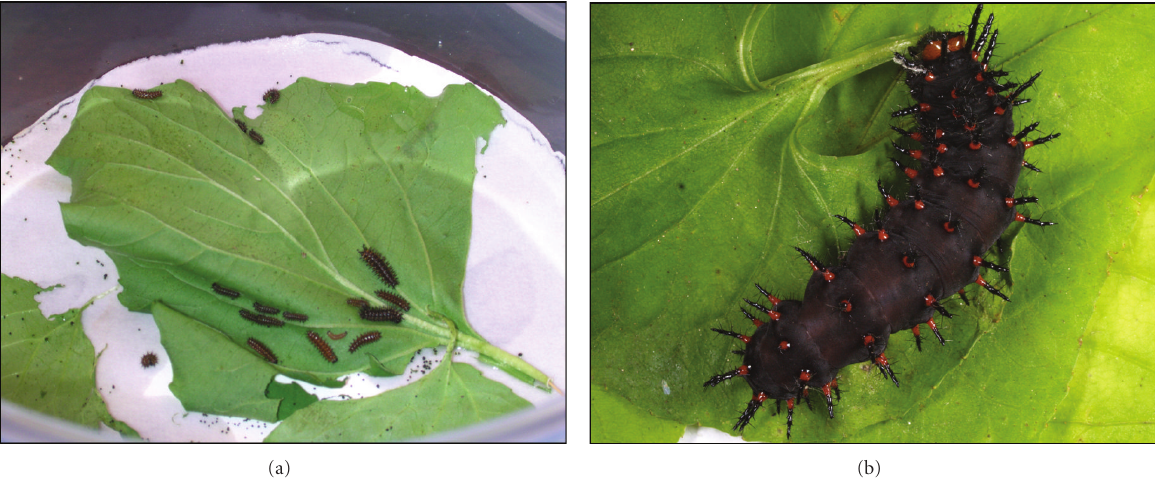
Figure 2: (a) First and second instars ( Argynnis diana ), approximately 10 days old; (b) sixth instar A. diana larvae, approximately 90 days